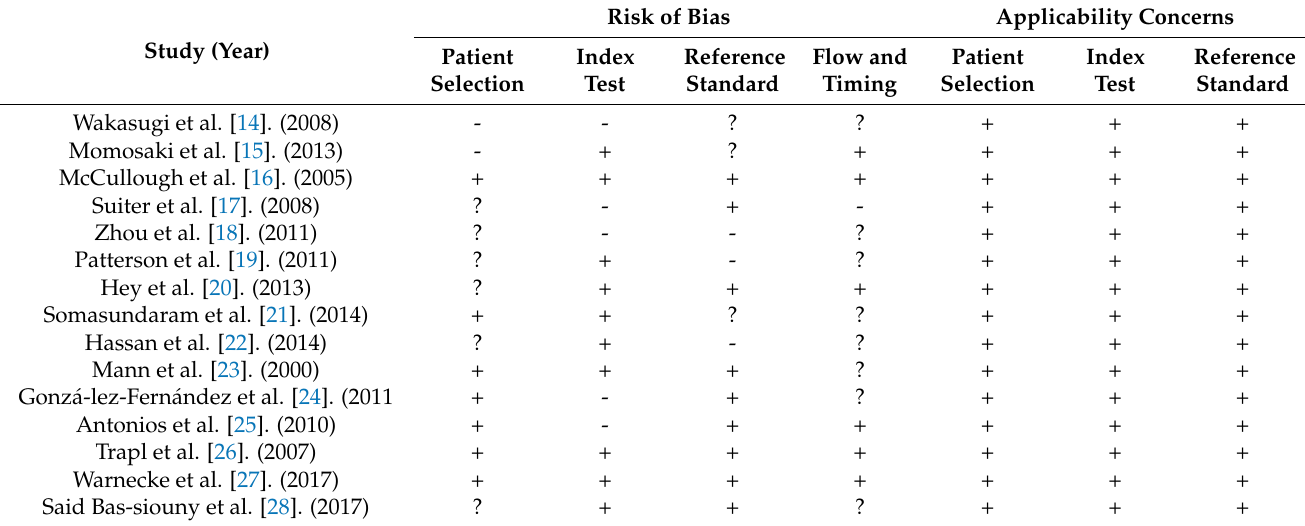
Table 2. Assessment of the quality of the included